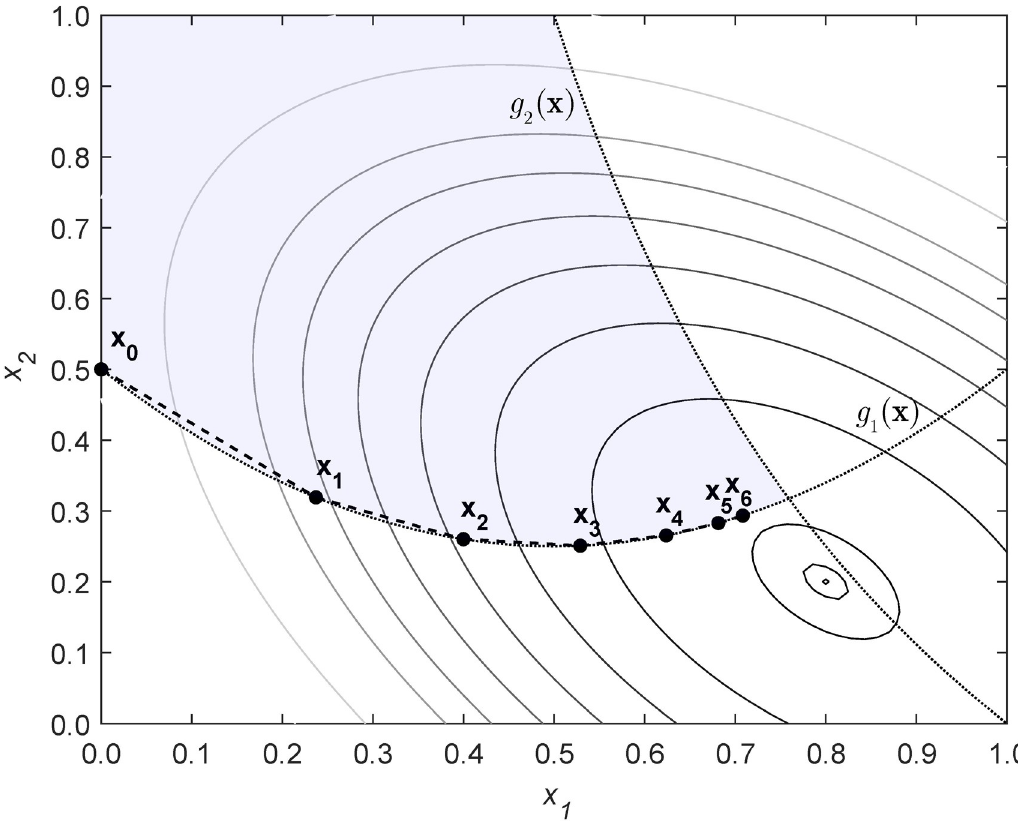
Fig 2. The first six iterations of a generic reduced gradient algorithm are shown for a simple illustrative example (see S1 Text for details). At each iteration of a reduced gradient algorithm, the variables are propagated to an improved point in which the constraints remain feasible. In this example, the feasible region (shaded in blue) lies above constraint g 1 and below constraint g 2 . In this case, the iterations proceed along the g 1 nonlinear constraint